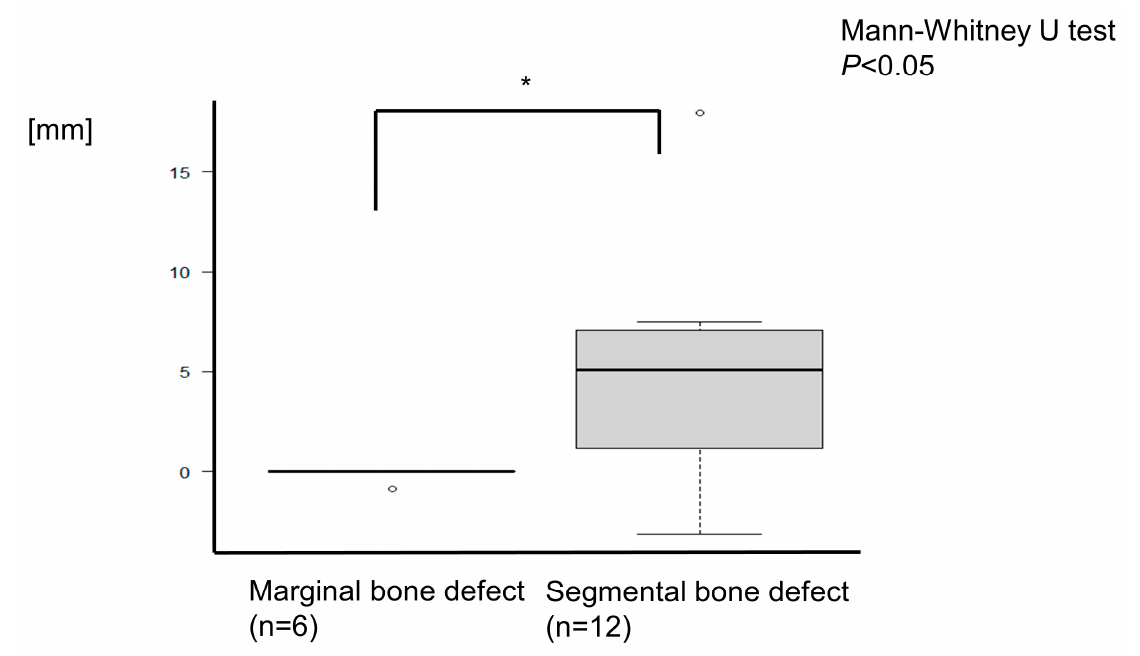
Figure 14. For the marginal bone augmentation, the mean length was − 0.15 ± 0.37 mm, whereas for the segmental defects, the mean length was 4.89 ± 5.34 mm. The mandibular length of segmental resection was augmented longer than marginal bone resection. There was a statistically significant difference (Mann–Whitney U test, * P < 0.05).